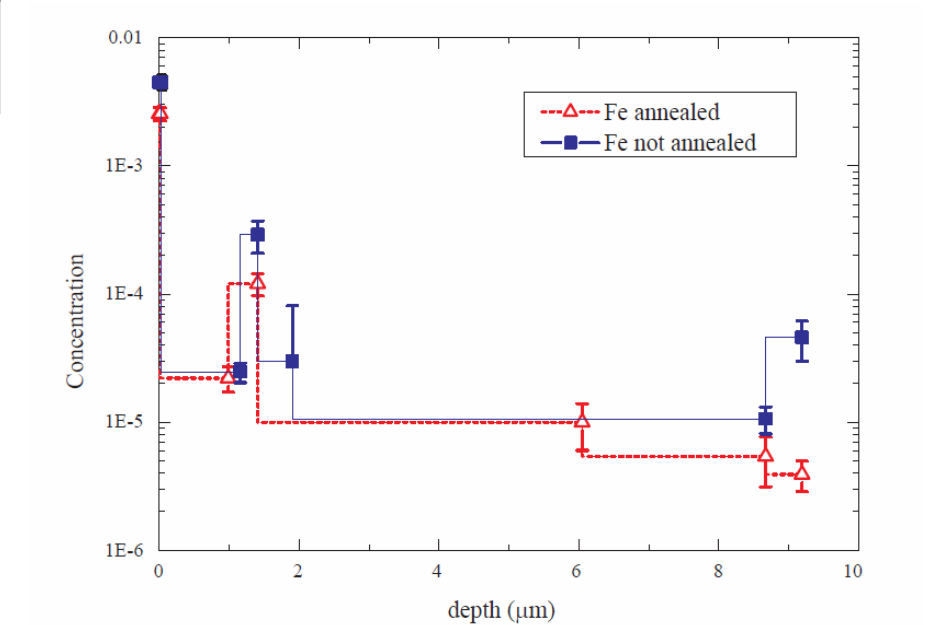
Figure 1 – Deuterium depth profile for the Fe samples exposed to deuterium plasma at 300 K to a fluence of F = 4×10 24 Dm -2 (-) not annealed and (----) annealed in vacuum at 1120 K for 1 h Slika 1 – Dubinski profil deuterijuma za uzorke Fe ozra č ene plazmom deuterijuma Рис . 1 – глубинный профиль дейтерия образца Fe, облучённый дейтериевой плазмой на 300 К и при флюенсе F = 4×10 24 Dm -2 (-) не разогретый и (----) разогретый в вакууме на 1120 К в течение 1